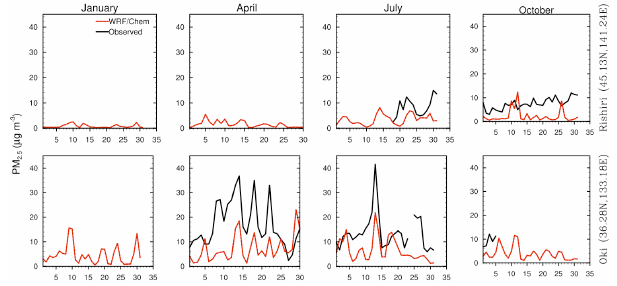
Fig. 6. Comparison of observed (black) and simulated (red) daily mean PM 2.5 concentrations ( µ g m -3 ) at Rishiri and Oki. Observed hourly values were taken from EANET data for 2000 and averaged when there was no missing value in 24-hours.